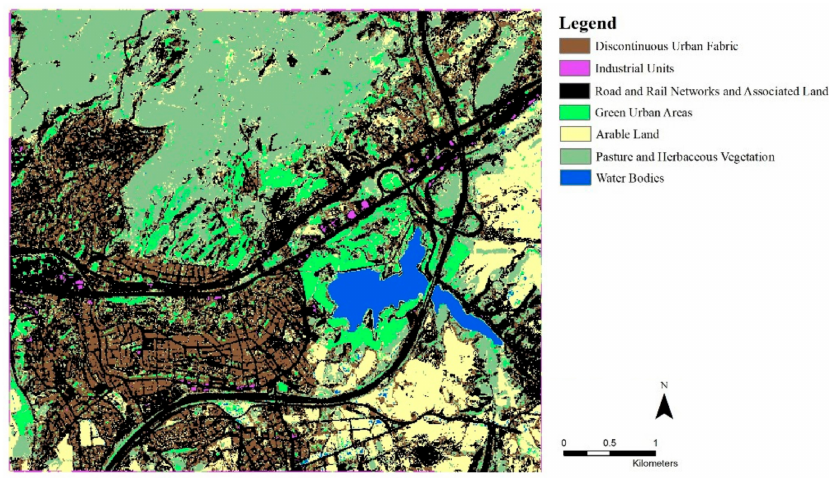
Figure 9. Land-use and land-cover map of the study